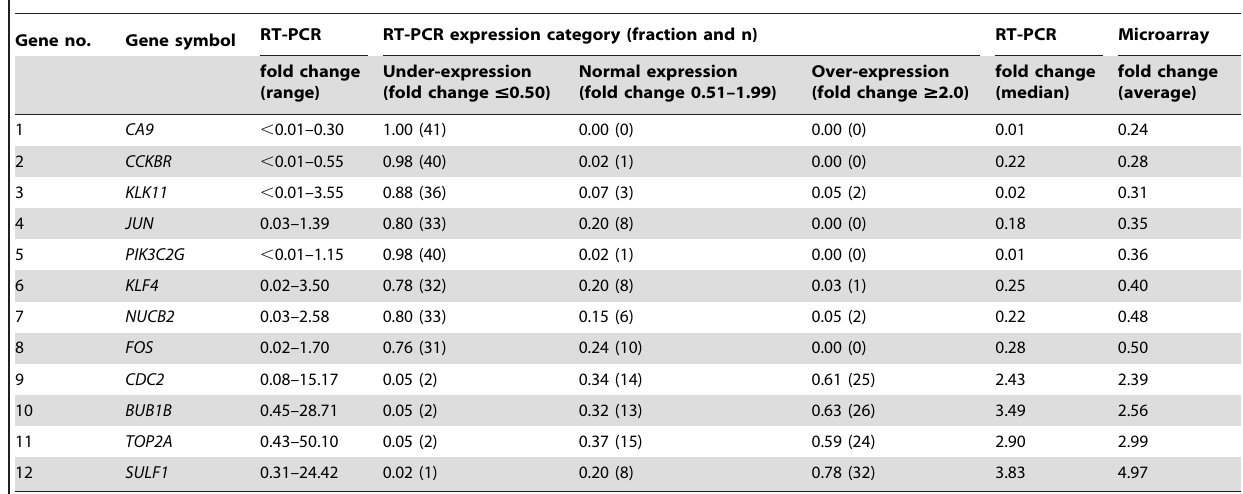
Table 4. Gastric cardia adenocarcinoma tumor/normal RNA expression fold change for genes validated by RT-PCR and comparison with microarray results (n=41 cases, 12